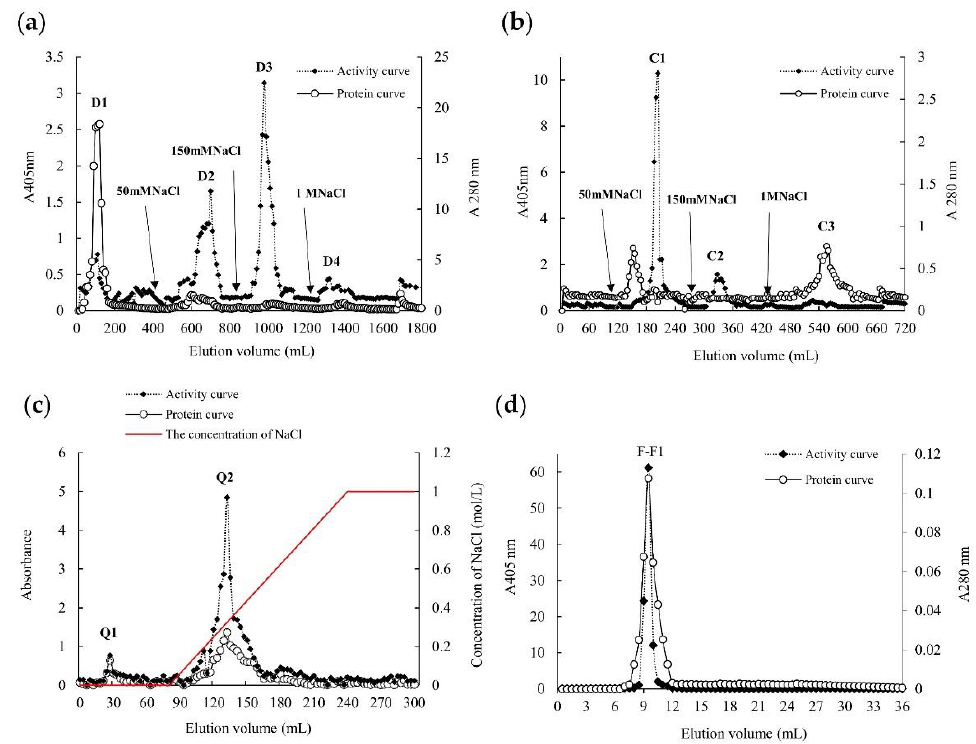
Figure 1. Elution profile of ORG on a ( a ) DEAE-Sepharose column, ( b ) CM-Sepharose column, ( c ) Q-Sepharose column, and ( d ) Superdex75 10/300 GL column. ORG represents purified Oudemansiella radicata α -galactosidase. Table 1. The purification efficiency of α -galactosidase from Oudemansiella radicata